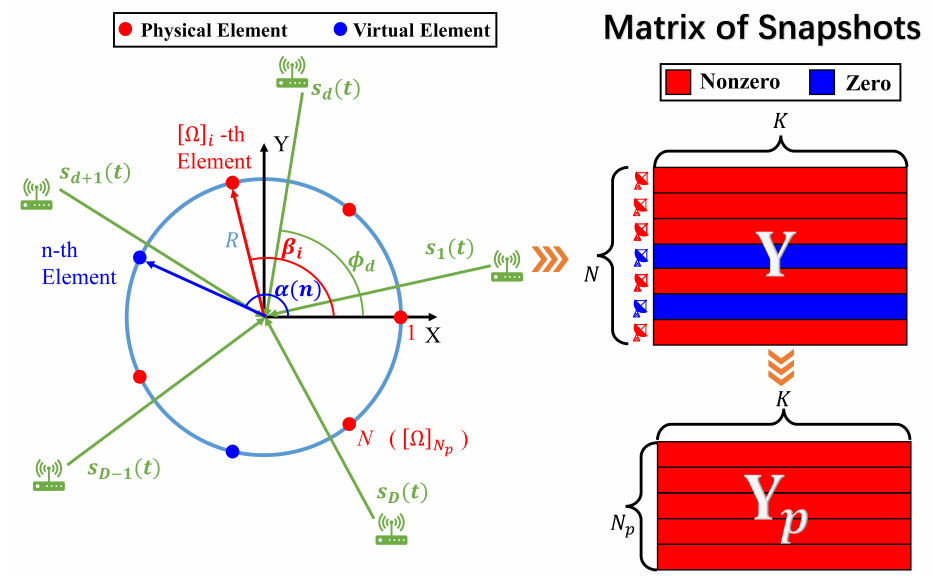
Figure 1. System